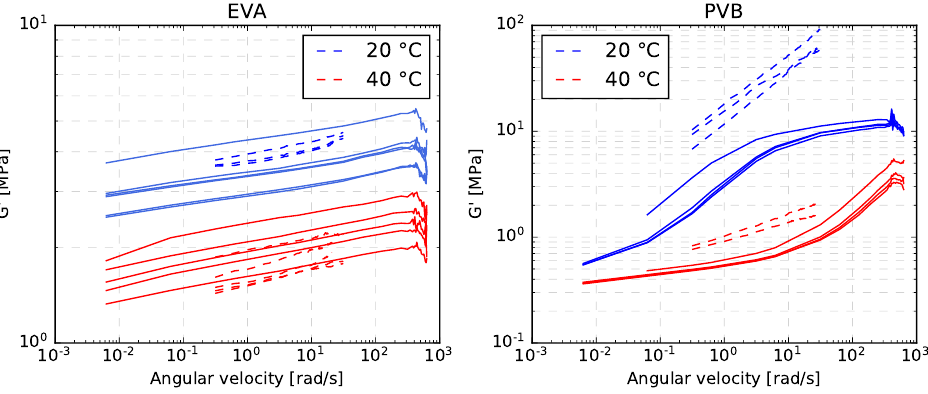
Figure 13. Comparison of all EVA and PVB shear and torsion measurements for temperatures of 20 ◦ C and 40 ◦ C (solid lines correspond to the dynamic torsion test, dashed lines to the single-lap shear